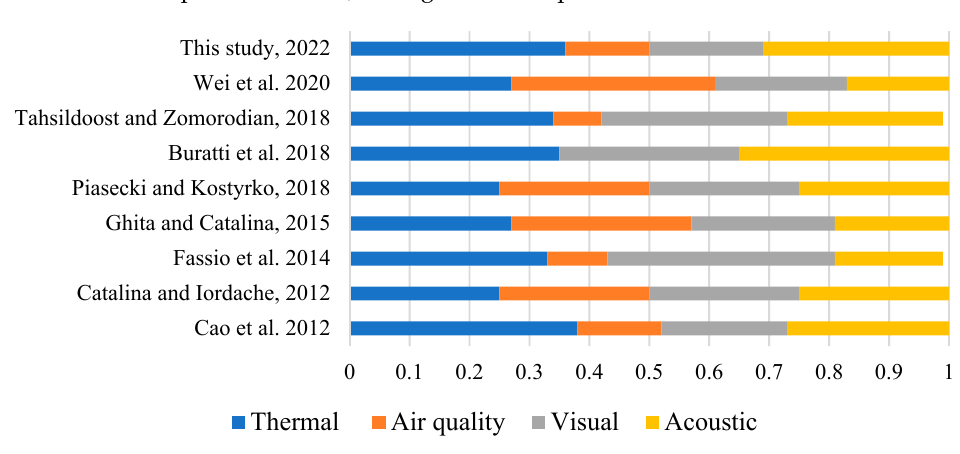
Figure 8. Comparison of the IEQ weightings from different studies [39–41,43,44,46–48] .